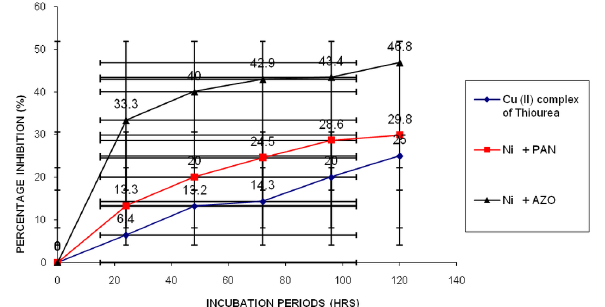
Fig. 6. Reduction of Mycelial growth of Collectotrichum capsici at 0.1 mg/ml